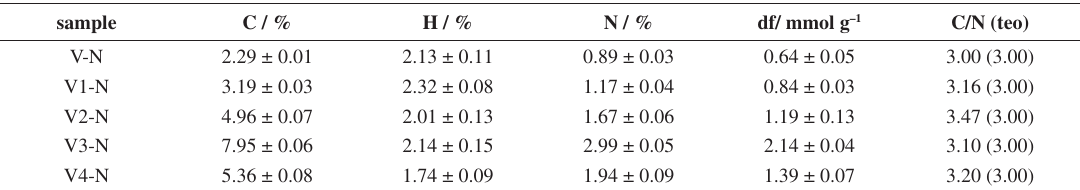
Table 2. Percentages of carbon (C) and nitrogen (N), the respective density of pendant organic molecules (df), the molar ratio (C/N) experimental and the molar ration C/N theoretical (teo).